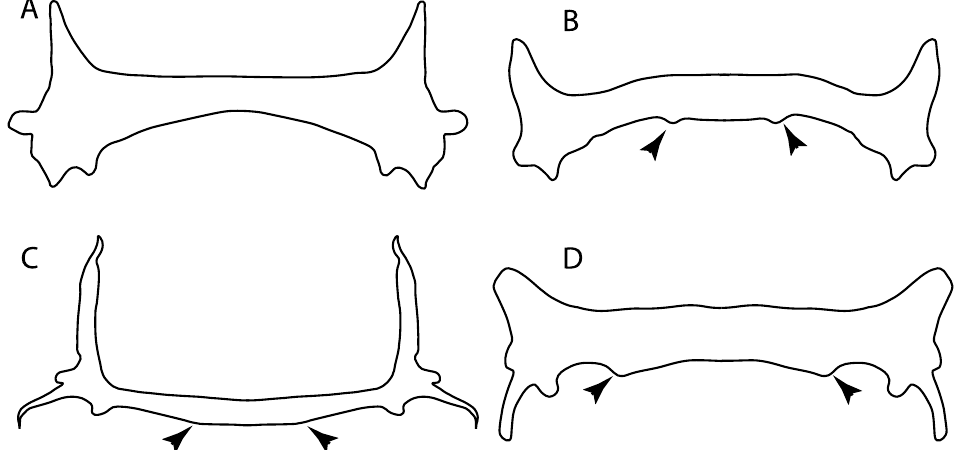
Figure 39. Pelvic girdle of selected taxa in dorsal view. State (0): ( A ) Bathyraja leucomelanos (MNHN 2005-2740) from Iglesias and Hartmann Text-Figure 13 in [84]. State (1): ( B ) Pseudobatos percellens (AMNH 8913); ( C ) Narcine bancroftii (CAS 18246); ( D ) Platyrhina sinensis (MNHN 1307). Arrowheads: postpelvic process.